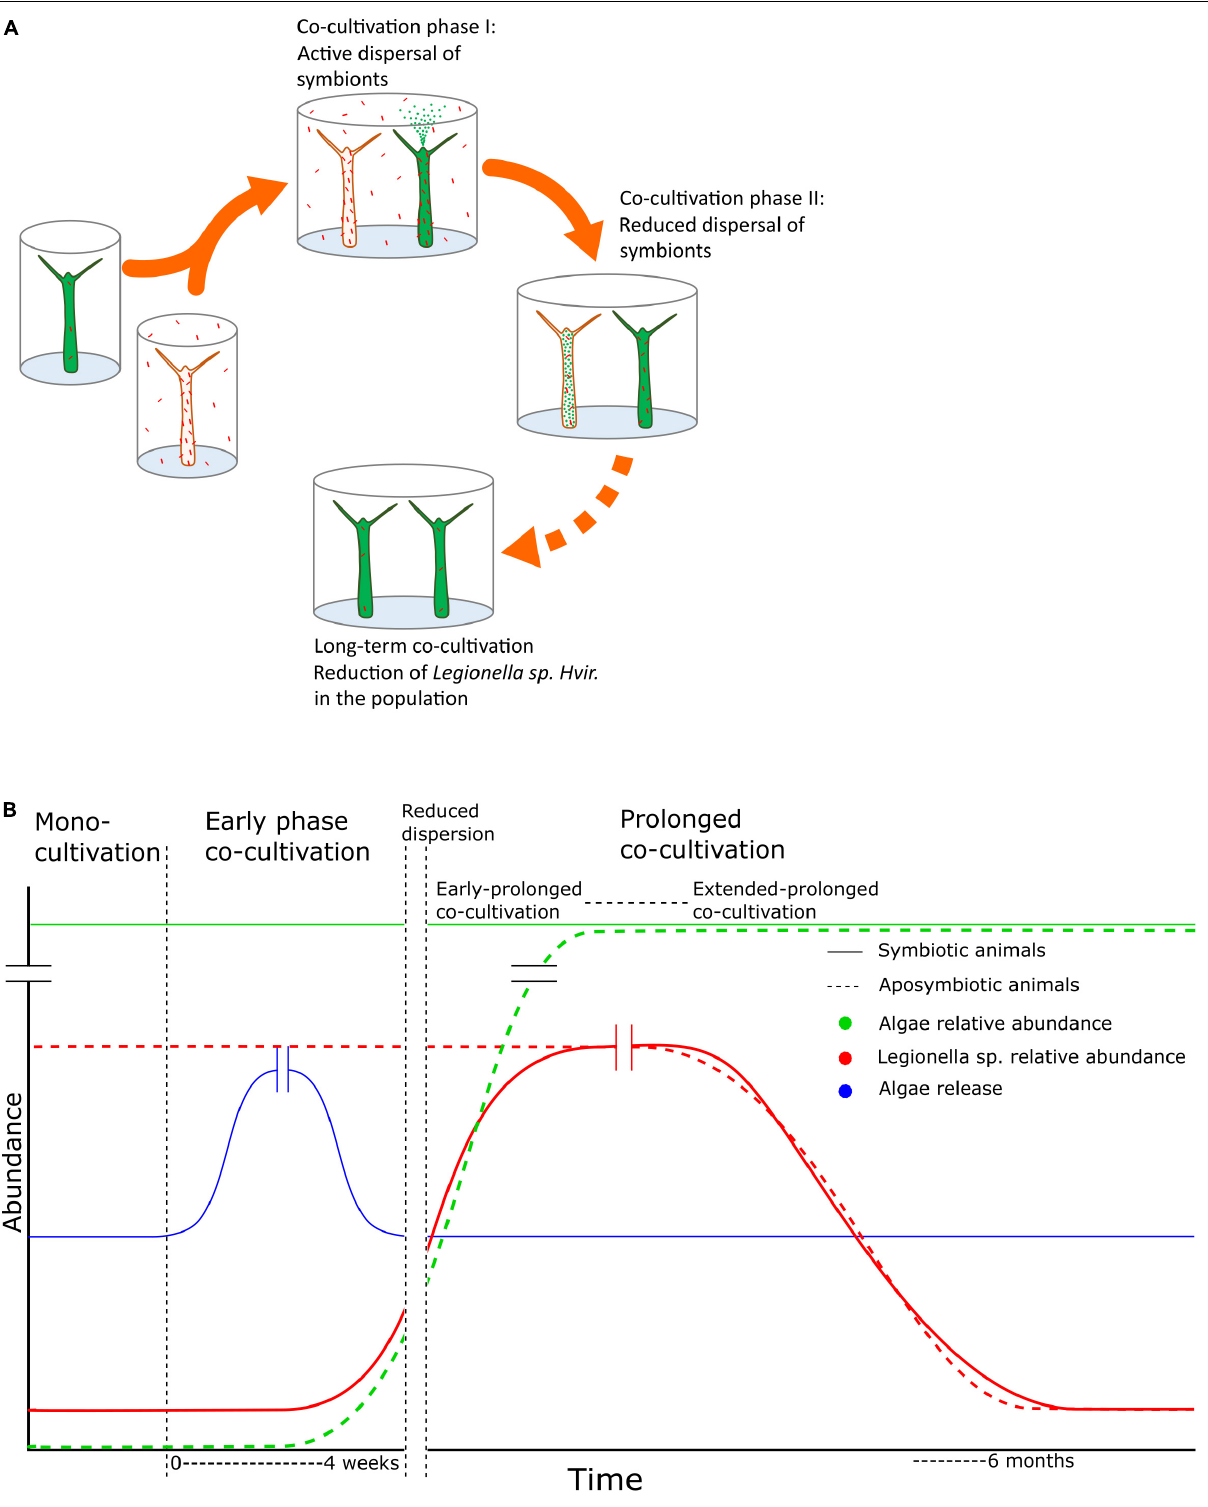
Frontiers in Microbiology |